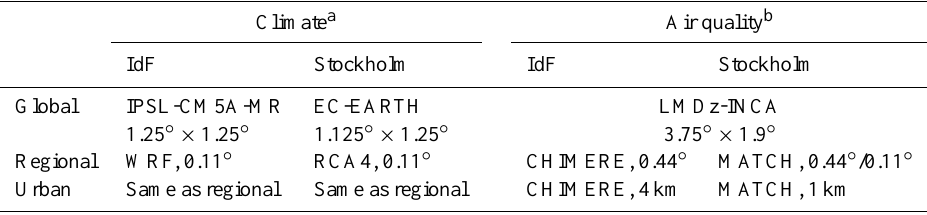
Table 1. Models (and their implemented resolutions) used for the simulations over the study